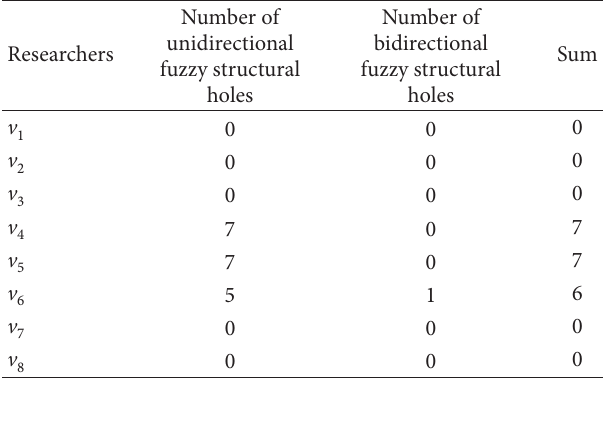
Table 1: Numbers of fuzzy structural holes of the researchers about the G-Y Research Team .